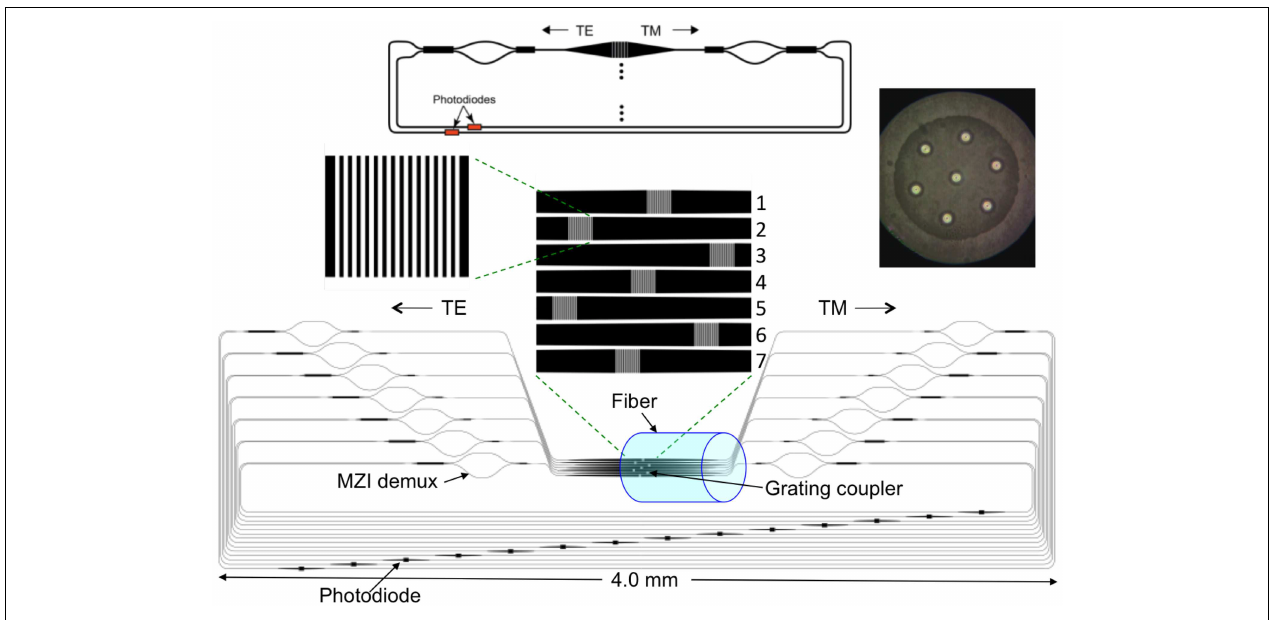
circuit shown in the bottom figure. The incoming fiber is tilted at the proper angle to the 1D grating couplers such that TE polarization couples to the left and TM polarization couples to the right.